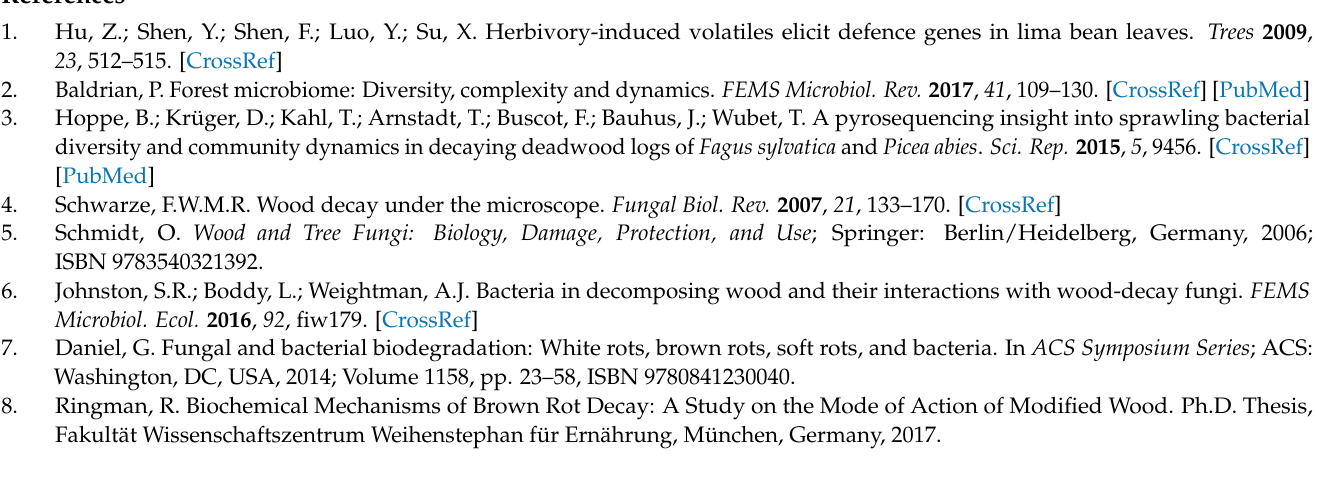
Shannon index; Figure S3: Scatter plot of the Simpson’s Index; Figure S4: Bray–Curtis distance plot; Figure S5: Antifungal activity assays of Actinobacteria and Penicillium species; Table S1: Samples collected from Villavieja (Le ó n, Spain); Table S2: Screening of PKS/NRPSs genes in Actinobacteria; Table S3: Screening of PKS/NRPSs genes in Penicillium sp.; Table S4: Results of cellulolytic and feruloyl esterase